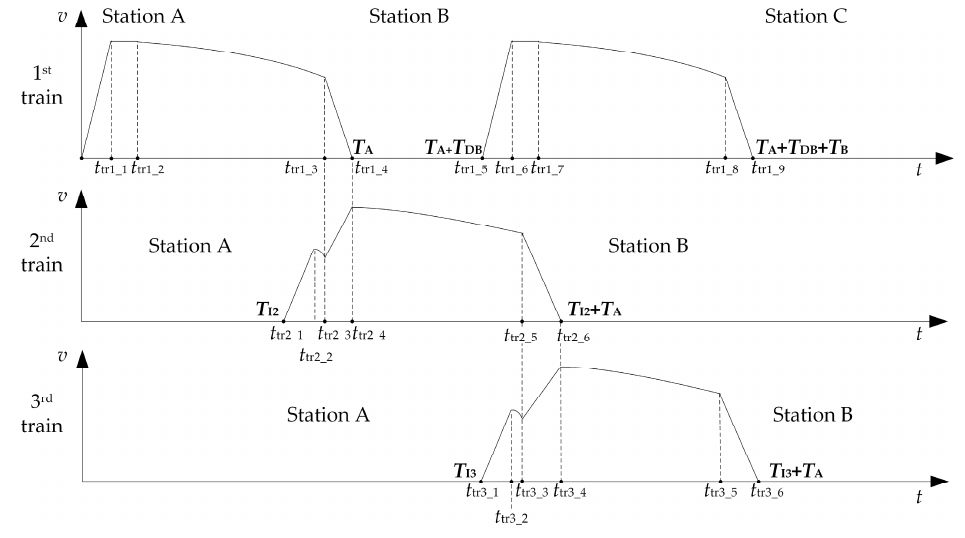
Figure 6. The driving curves for multi-train system when the 3rd train operates under five-mode operation.